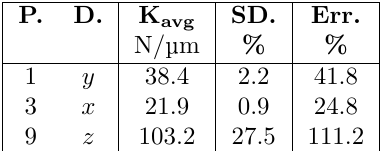
Table 6: 3-axis CNC, test 1.2: average stiffness from measurements. At different positions (P.) and directions (D.).